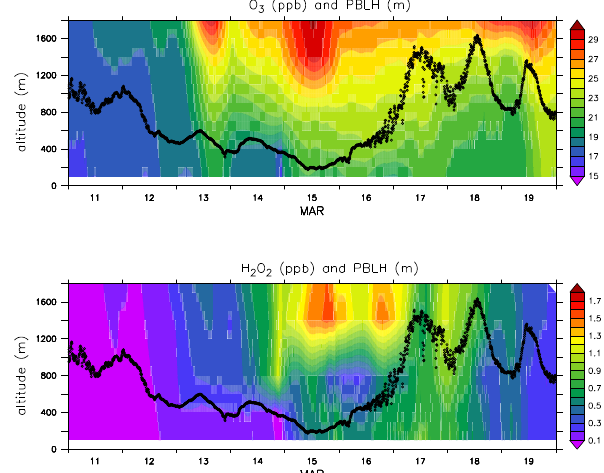
Figure 7. EMAC simulation of O 3 (top) and H 2 O 2 (bottom) verti- cal profiles versus time. Superimposed is the height of the planetary boundary layer. The increase in boundary layer height in the night from 15 to 16 March is associated with an increase in peroxide mix- ing